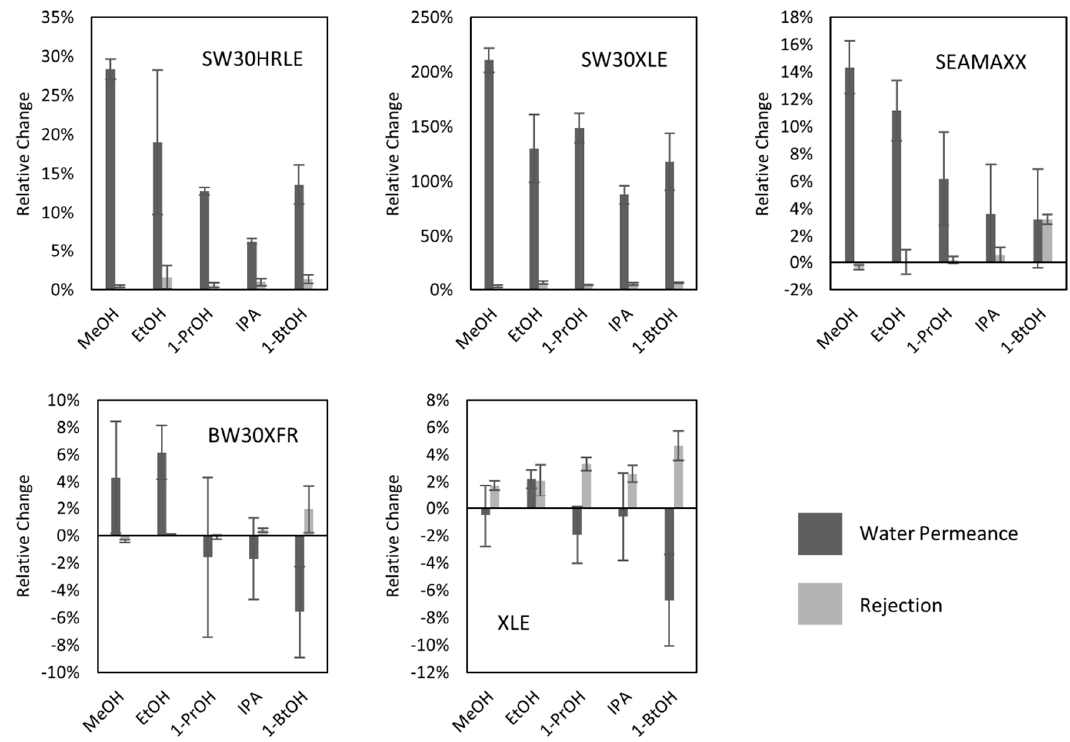
Figure 4. Relative change in water permeance ( dark ) and sodium chloride rejection ( light ) after contact with different alcohols for 5 min for seawater ( top row ) and brackish water ( bottom row ) desalination membranes. Error bars represent one standard deviation for at least three measurements.